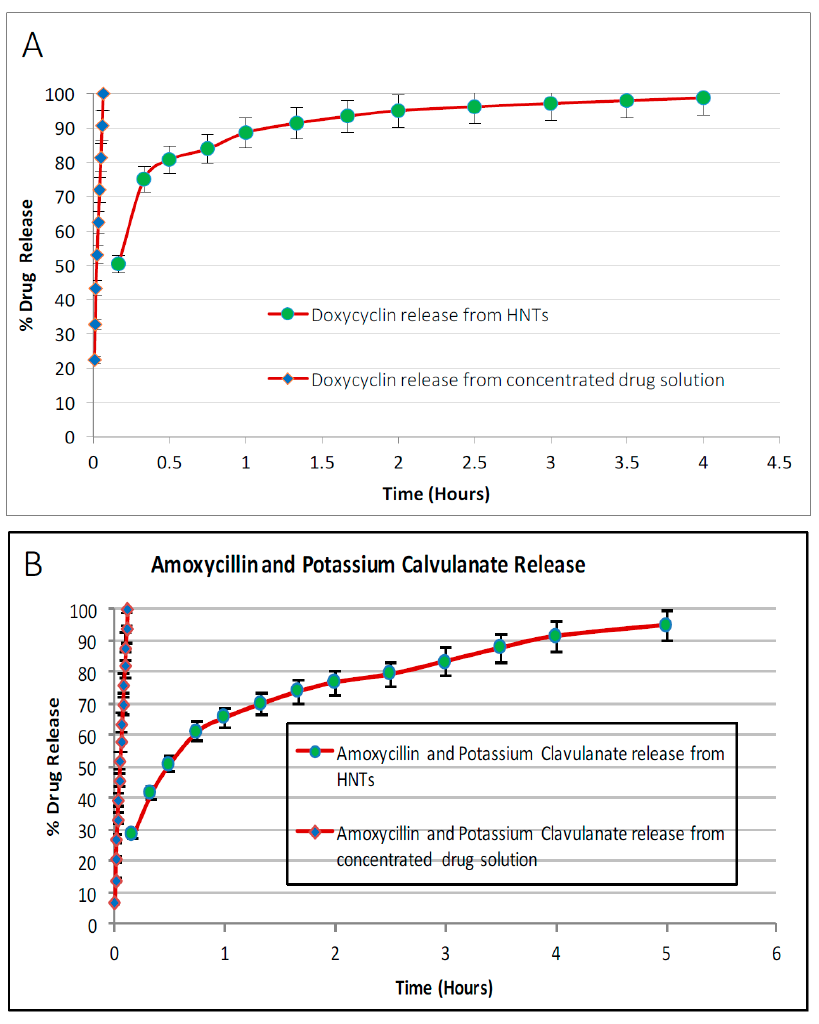
Figure 5. Antibiotic release from HNTs. ( A ) Doxycyclin; ( B ) Amoxycillin and Potassium Calvulanate. n = 4 trials.